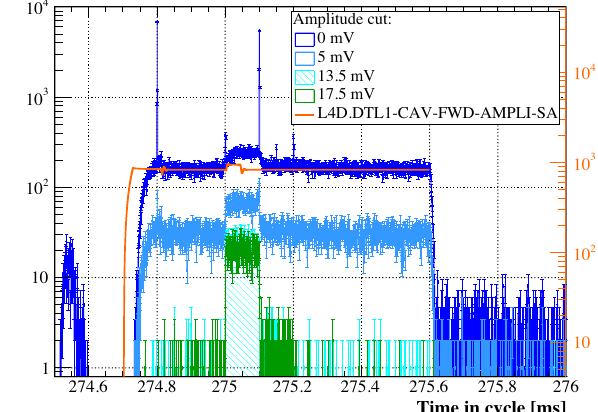
FIG. 9. Distribution of reconstructed IEs over amplitude and time in LINAC4 machine cycle period for data collected during the controlled loss experiment in 2019 data-taking campaign.